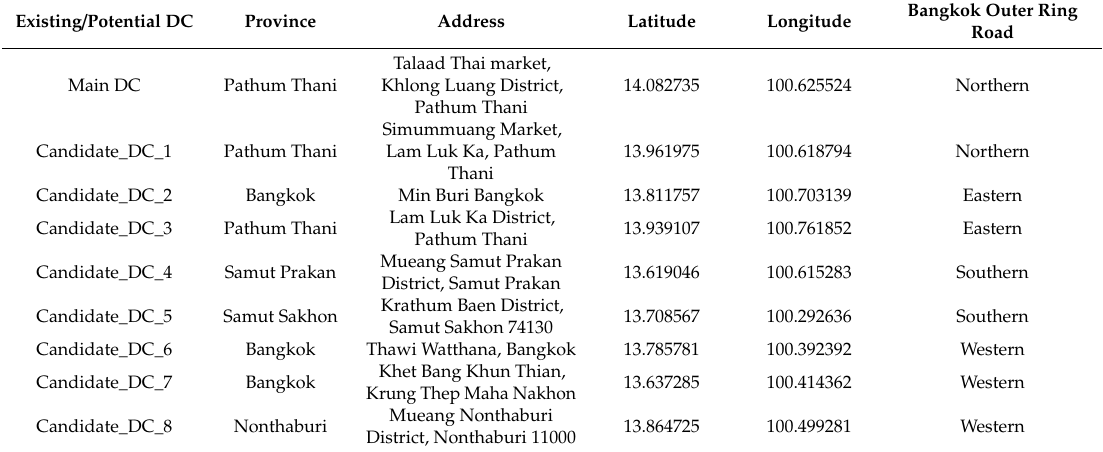
Table 2. Existing and candidate DC.